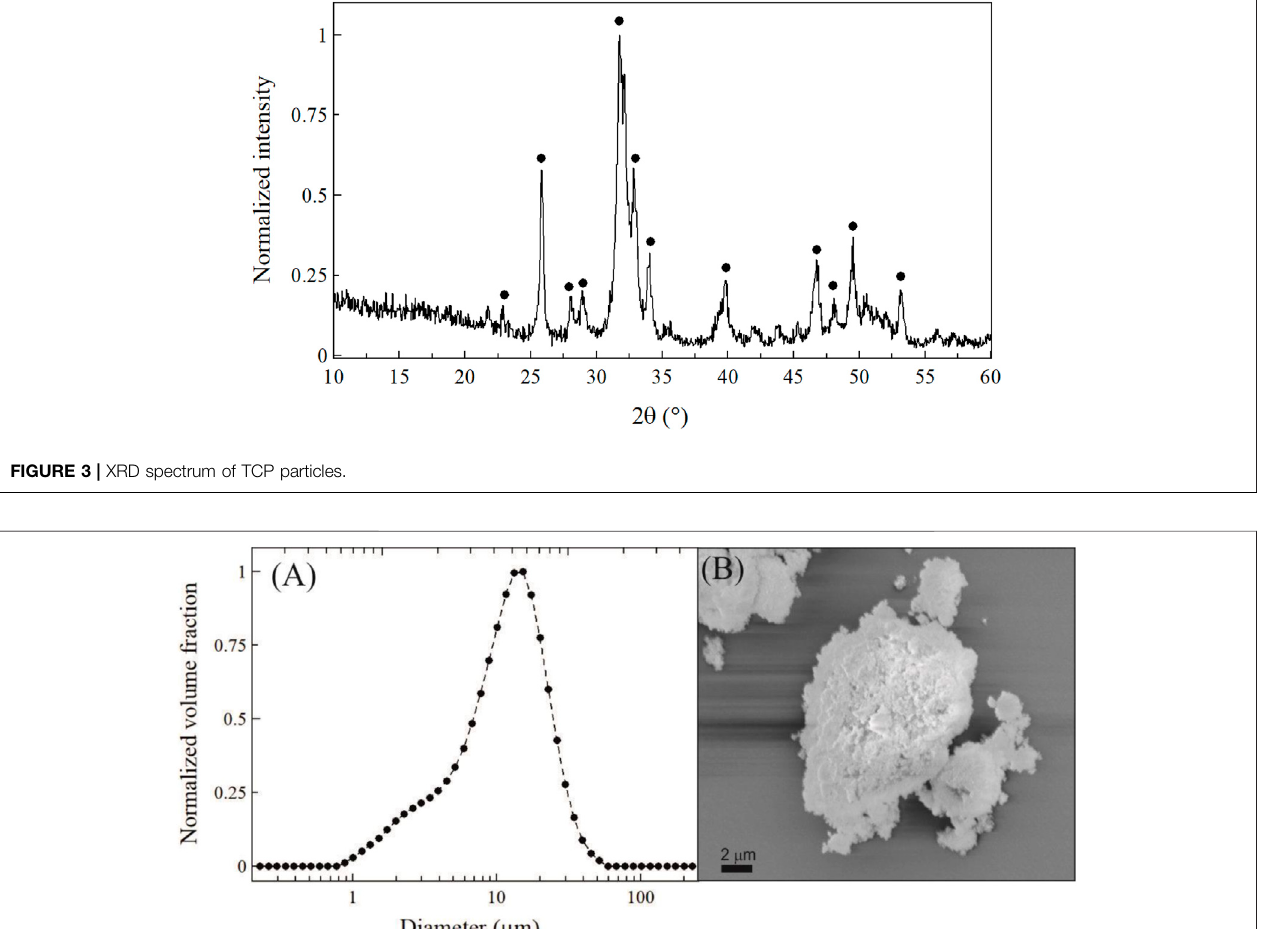
Frontiers in Materials |